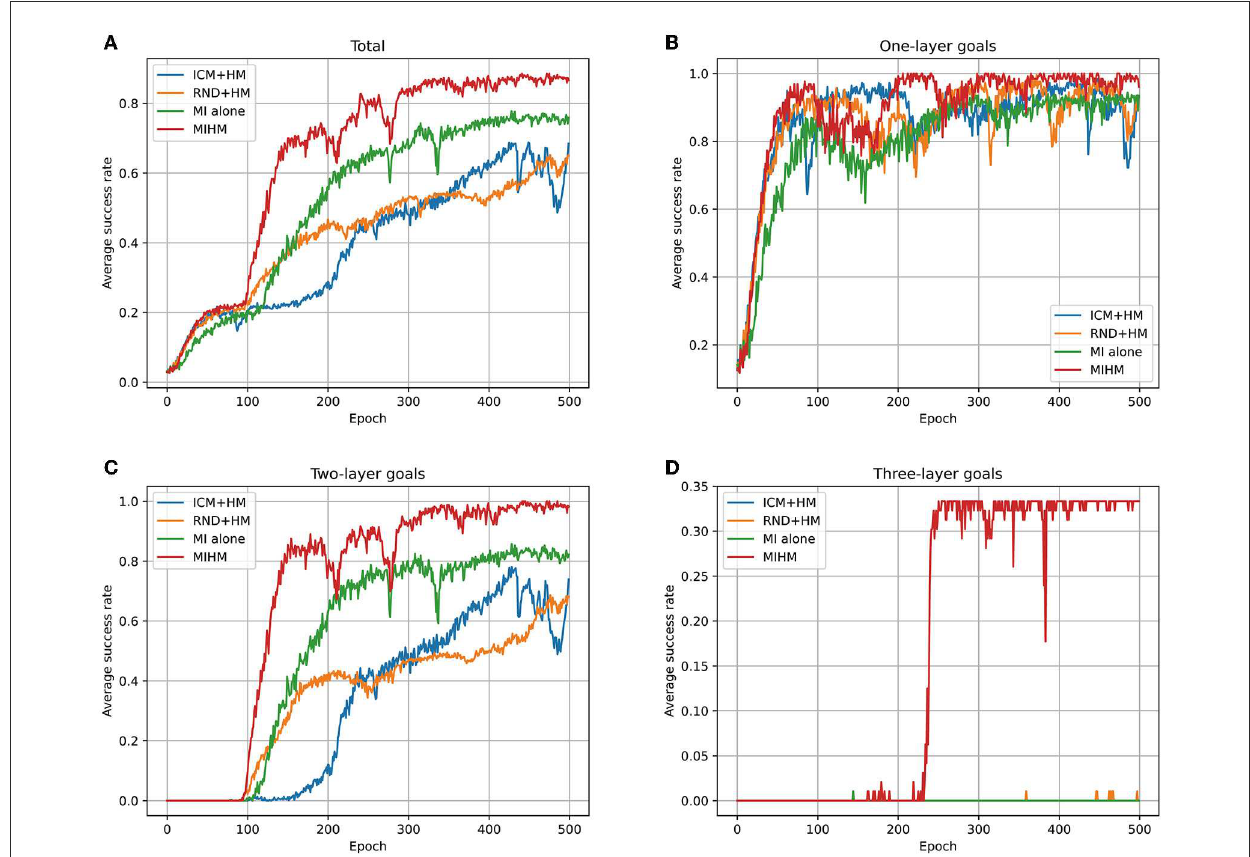
FIGURE7 Learning processes of ICM + HM, RND + HM, MI alone and MIHM for different categories of goals. (A) Shows the variations of average success rates of all 35 goals. (B–D) Show the variations of the average success rates of one-layer goals, two-layer goals and three-layer goals, respectively. Compared with original ICM and RND, ICM + HM and RND + HM increase the final success rates of one-layer goals and two-layer goals by approximately 10% and 30%; MI alone increases the final success rates of one-layer goals and two-layer goals by 10% and 50%. These results prove that overcoming either uncontrollability or distraction can improve the performance of curiosity-motivated methods.